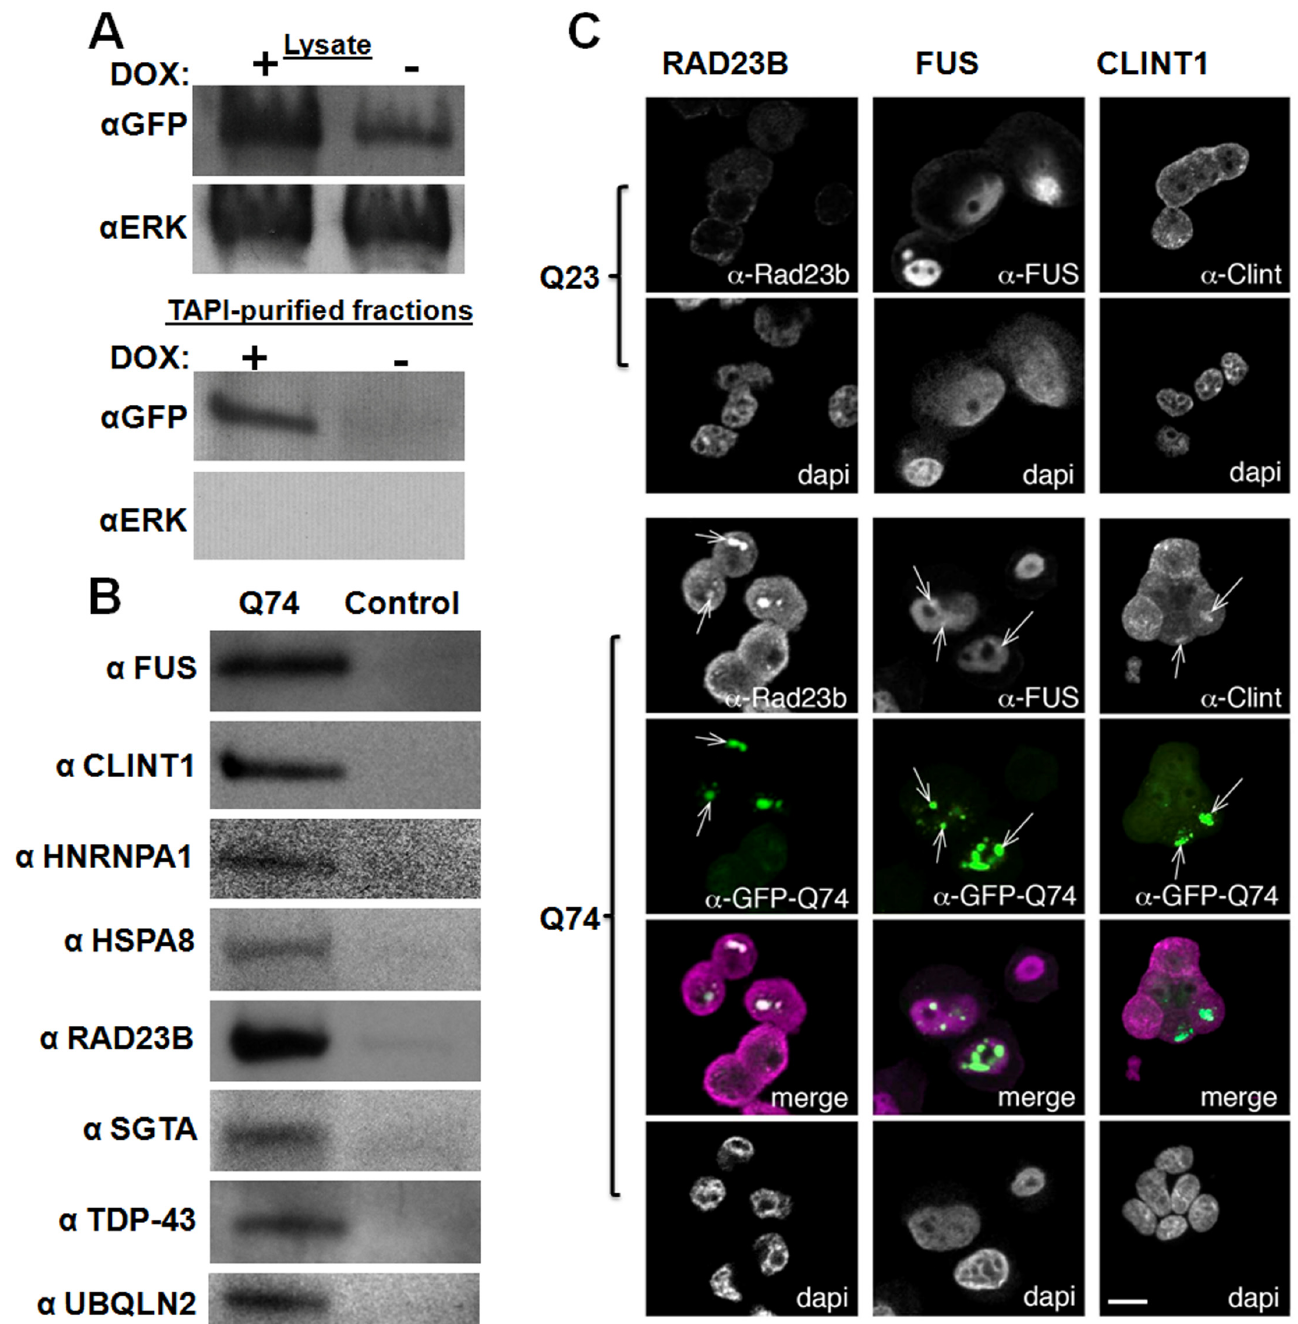
Fig 5. Confirmation of polyQ-associated proteins from PC-12 cells identified by TAPI. (A) Western blotting shows that the addition of doxycycline to the PC-12 cell model induces the expression of HttQ74-GFP, resulting in aggregates that can be purified by TAPI. The kinase ERK is probed as a negative control; ERK was never identified by mass spectrometry, so is not expected to co-fractionate with polyQ aggregates. (B) Western blot analysis of TAPI- purified polyQ aggregates from PC-12 cells confirms the presence of several disease-associated proteins only in the Htt-Q74 samples. All proteins migrated near their predicted molecular weights. For control, the TAPI procedure was conducted in parallel on the induced Htt-Q23 cell line (FUS, TDP-43, UBQLN2, HNRNPA1) or the un-induced Htt-Q74 cell line (CLINT1, HSPA8, RAD23B, SGTA). (C) Confocal microscopy shows localization of identified proteins to Htt- Q74 aggregates in PC12 cells. (left) RAD23B, nominally a DNA repair protein, localizes to nuclear Htt-Q74 inclusions but not cytoplasmic inclusions. (middle) FUS, an RNA-binding protein localizes to nuclear and cytoplasmic Htt-Q74 inclusions. (right) CLINT1, a clatherin-interacting protein, is observed in cytoplasmic Htt-Q74 aggregates. Arrows indicate foci with co-localized proteins. Green = GFP; Magenta = CLINT1, FUS or RAD23B in merge.